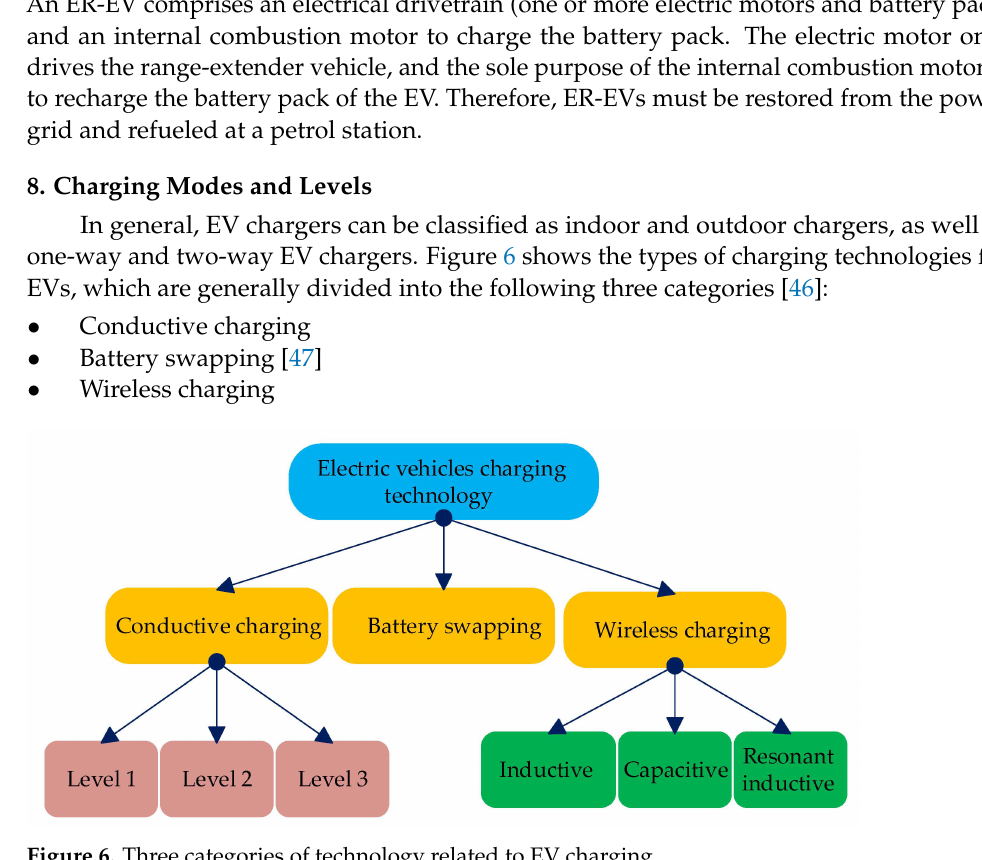
Figure 6. Three categories of technology related to EV